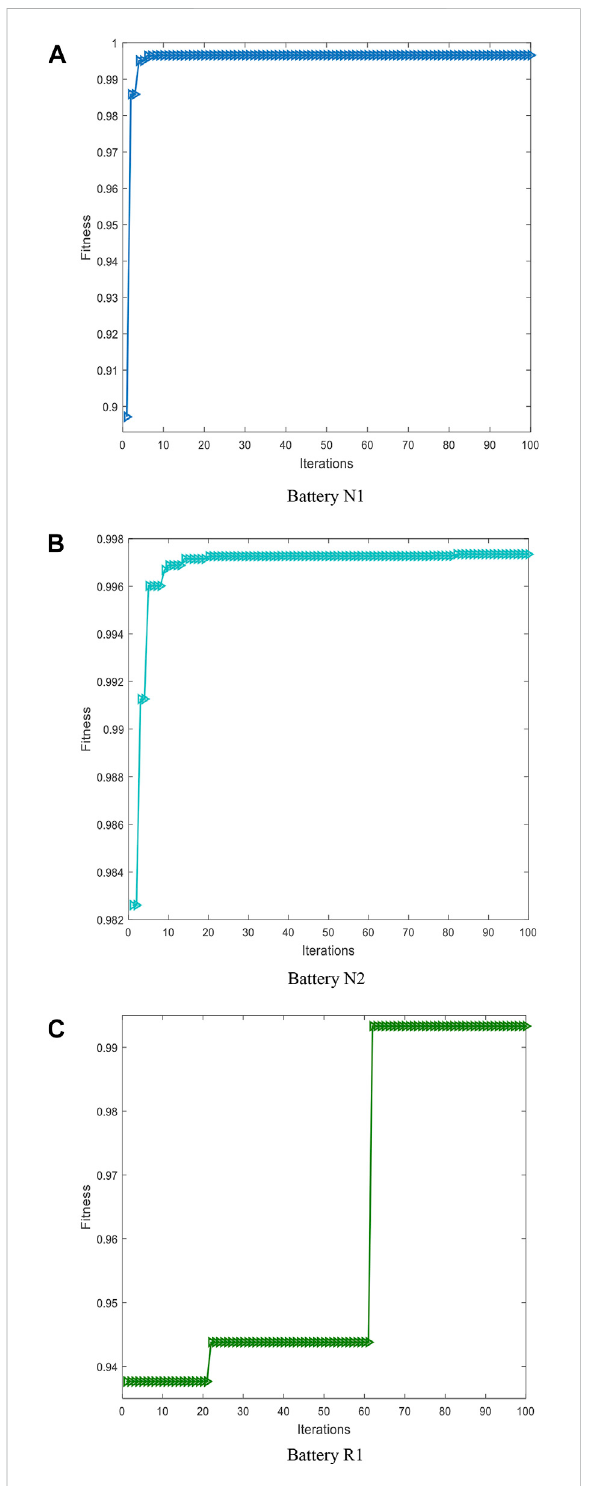
FIGURE 7 The procedures for optimizing the initial parameters of the BLS network using the PSO